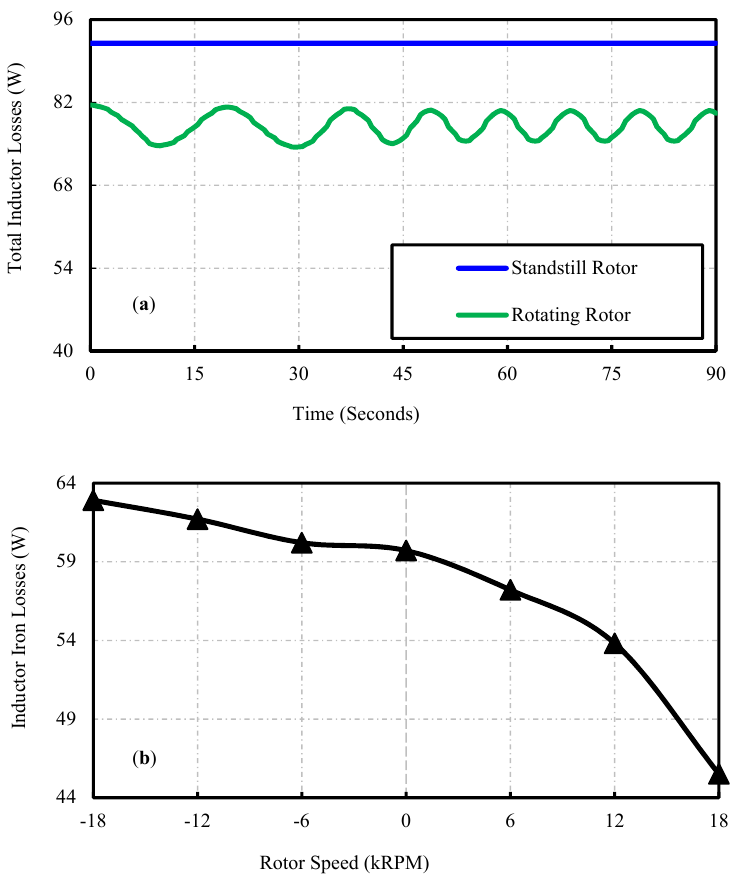
Figure 11. Experimental Setup to Test the Rotational Inductor.